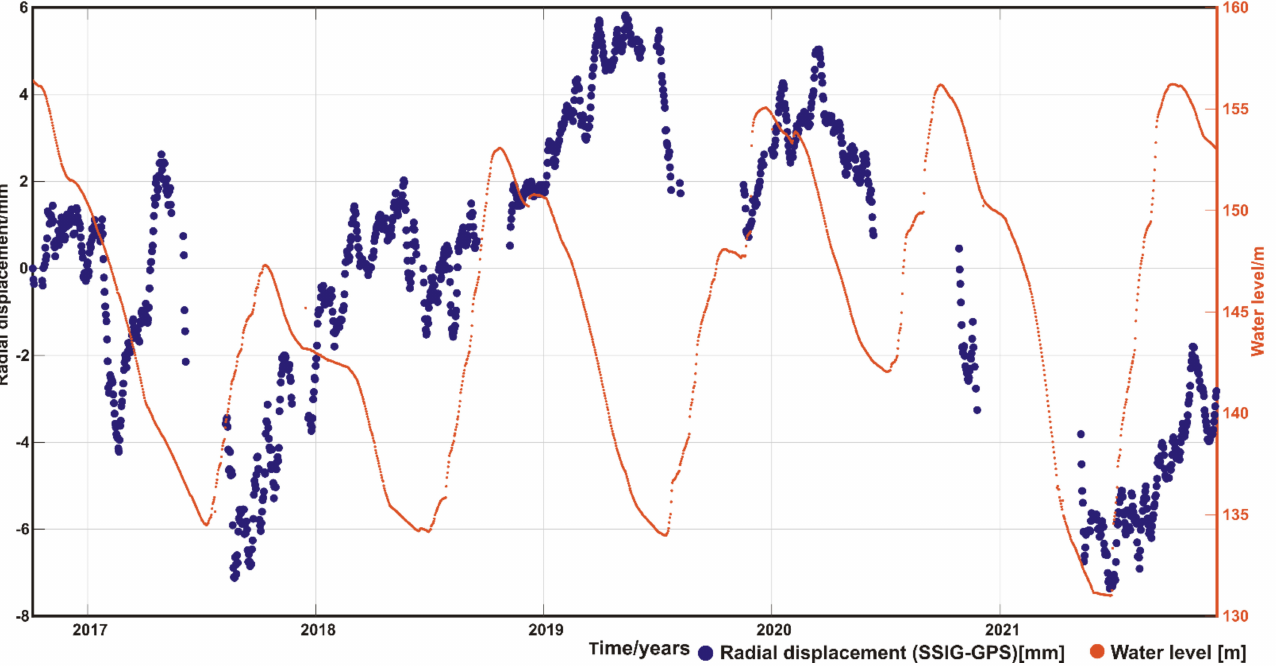
Figure 11. Local radial displacements of the Sanalona dam through GPS measurements at the SSIG